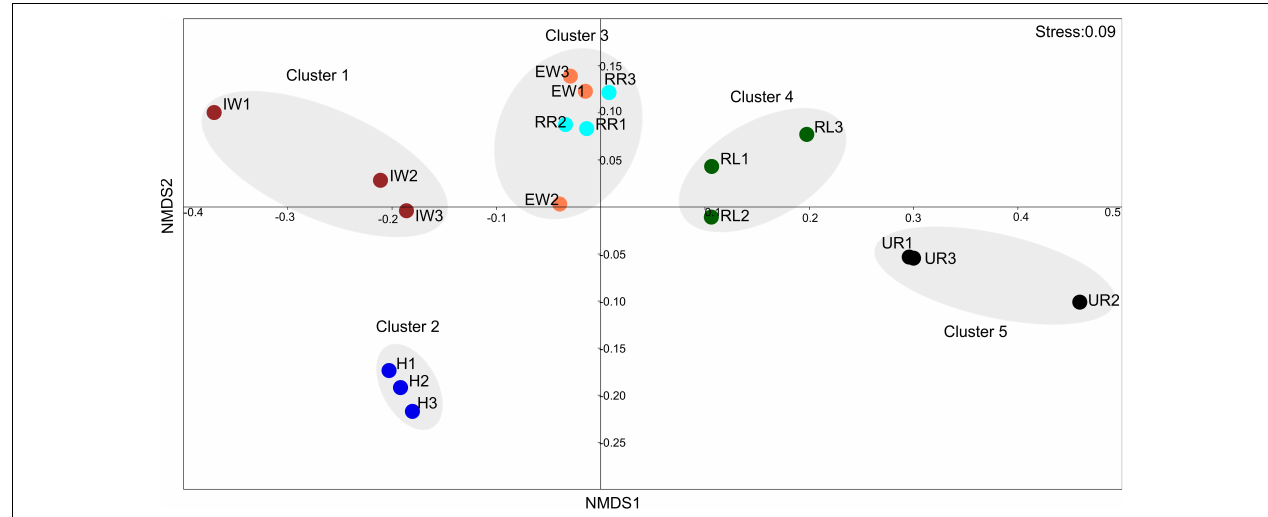
FIGURE 5 | Non-metric multidimensional scaling plot displaying similarities between ARG profiles of hospital wastewater, WWTP wastewater, and environmental water samples. Three replicate samples taken from each location are represented by 1, 2, and 3 after the symbol. Symbols in the figure represent the following: H, Hospital wastewater; IW, Incoming sewage water from the wastewater treatment plant; EW, effluent wastewater from the wastewater treatment plant; UR, surface water from Svartån river upstream of Örebro city; RR, surface water from Svartån river water downstream of the wastewater treatment plant; and RL, surface water from Hjälmaren lake downstream of the wastewater treatment plant. A low-stress value (0.09) indicates a good quality